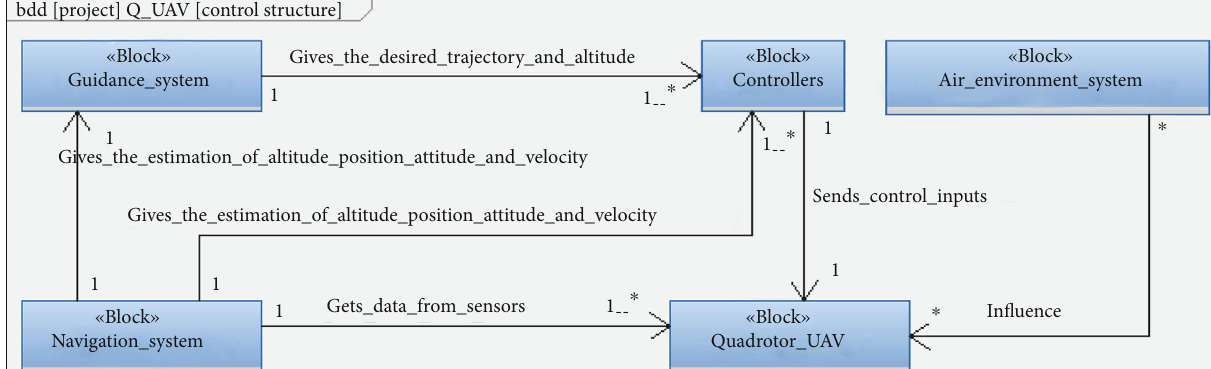
Figure 1: Block de fi nition diagram of autonomy architecture for a